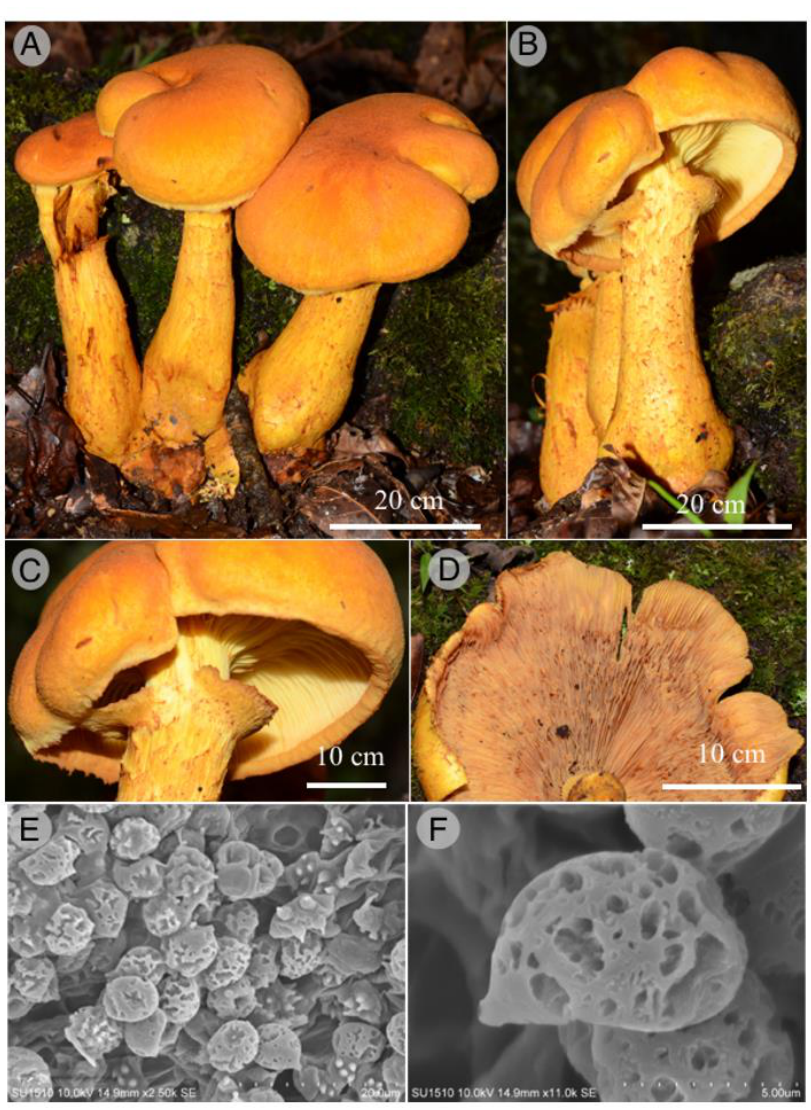
Figure 2. Gymnopilus guzmanii . ( A , B ): basidiomata; ( C , D ): detail of annulus and hymenophore; ( E , F ): SEM of basidiospores.